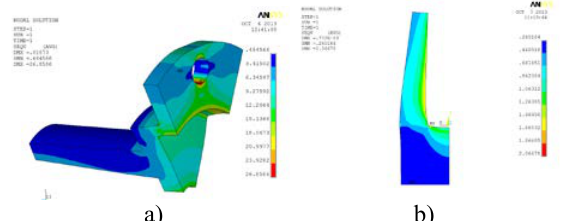
Fig. 13. Equivalent stresses in mandrel (a) and spindle (b).